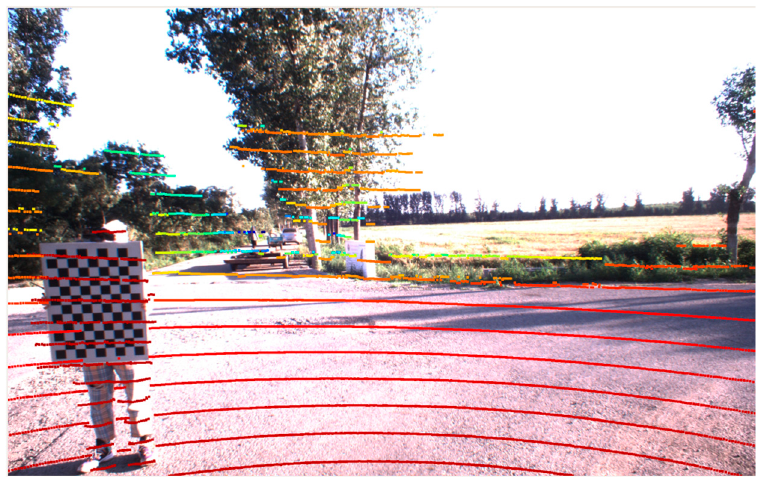
Figure 8. Visualization of spatial registration results between the LiDAR and the camera.